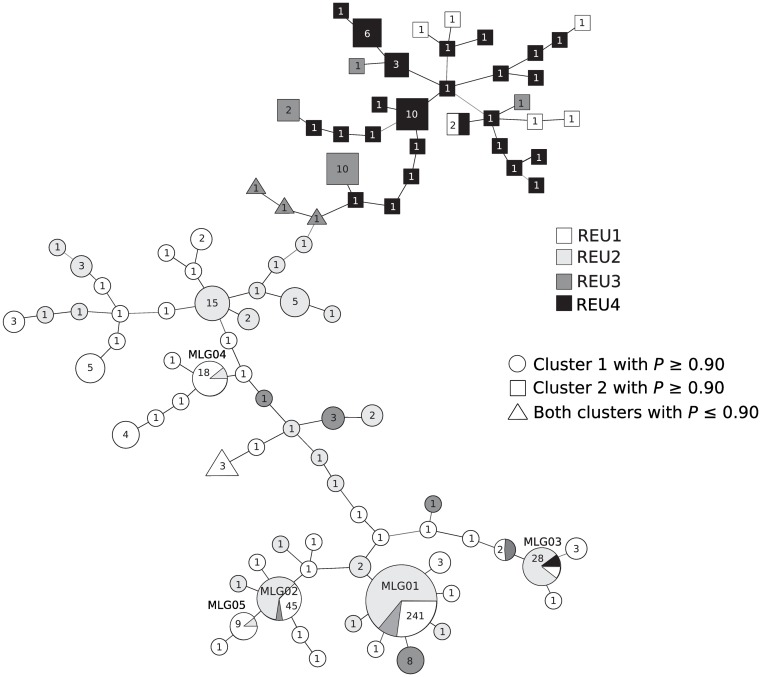
Network of multi-locus genotypes (MLG) based on shared allele distance.The number of colonies sharing each MLG is indicated inside each node and the geographic origin of the colonies is represented by colors. The node shape represents the result of the clustering analysis: circles, MLGs assigned to cluster 1 (see Fig 4) with a probability ≥ 0.90; squares, MLGs assigned to cluster 2 (see Fig 4) with a probability ≥ 0.90; triangles, MLGs assigned to one cluster or the other with a probability ≤ 0.90.